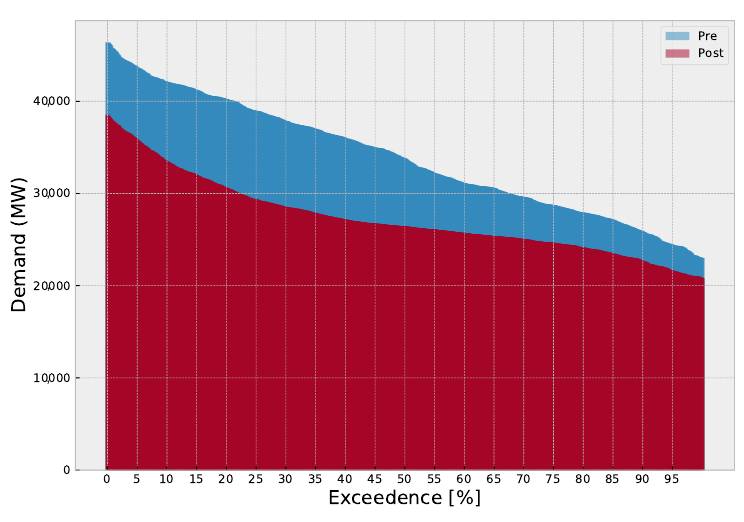
Figure 4. Load duration curve for pre- and post-lockdown actions (w/c 02/03/20 and 23/03/20) showing the decrease in the post-action scenario with the highest decrease in peak and lowest in the base